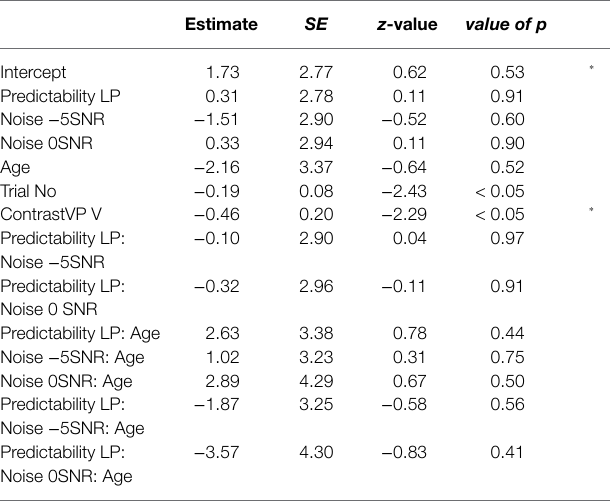
TABLE 4 | Model outcomes for the confidence rating analysis (distractor subset).